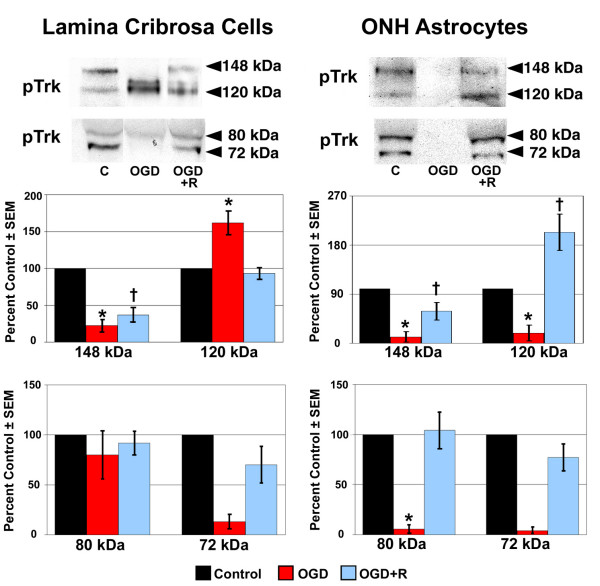
Phosphorylated Trk protein expression following exposure to and recovery from Oxygen-Glucose Deprivation. Lamina cribrosa cells and ONH astrocytes were exposed to OGD for 48 hours (OGD) or to 48 hours OGD followed by recovery for 24 hours (OGD+R). Cells exposed to growth media and 95% air/5% CO2 for 48 hours served as controls (C). Cell lysate was separated by SDS-PAGE and the density of unsaturated bands was measured for each blot. A representative blot for each phospho-Trk receptor isoform is shown. Band density reported as mean percent of the control ± SEM (n = 3) is shown graphically beneath the blots. * indicates p < 0.016 for OGD compared to C and OGD+R; † indicates p < 0.016 for OGD+R compared to C (one way analysis of variance [ANOVA] followed by validation using Student-Newman-Keuls tests).